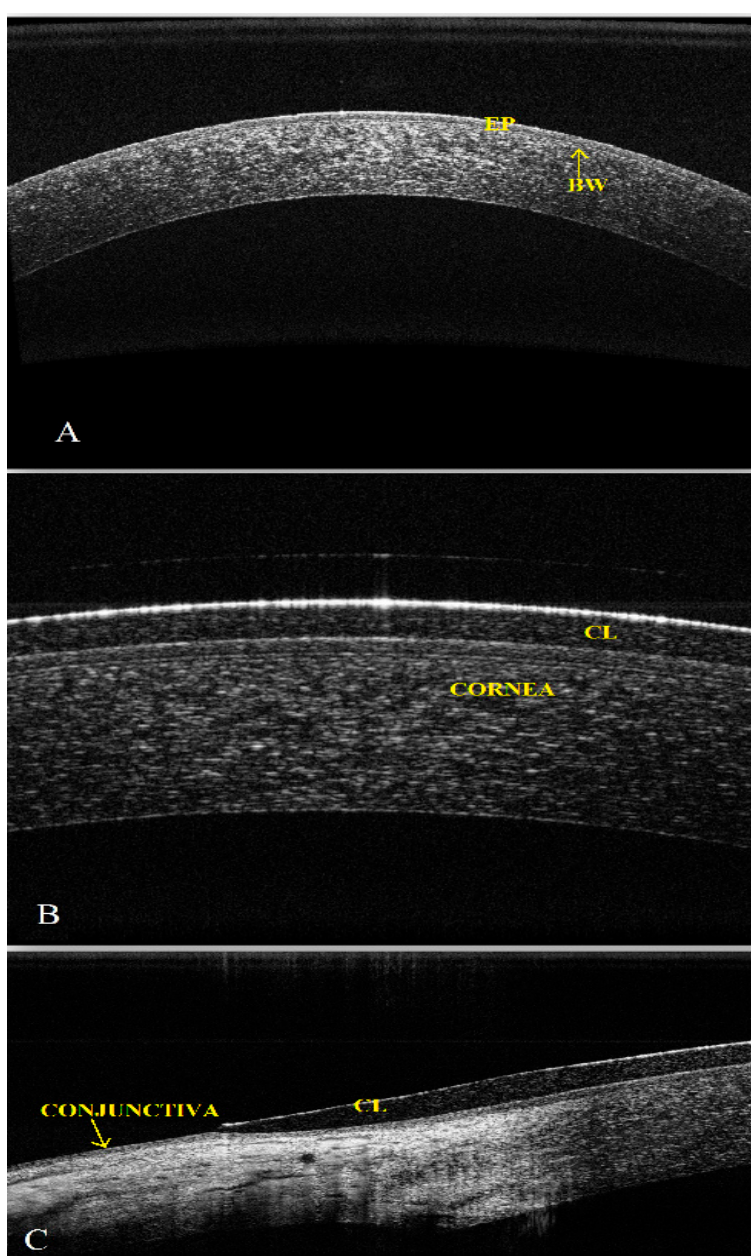
Figure 2. Optimal fitting of a soft CL. The central part of the cornea ( A ). The cornea with a well-fitted soft CL Dailies, Ciba Vision ( B,C ) (EP, epithelium; BW, Bowman membrane). soft CL Dailies, Ciba Vision ( B , C ) (EP, epithelium; BW, Bowman